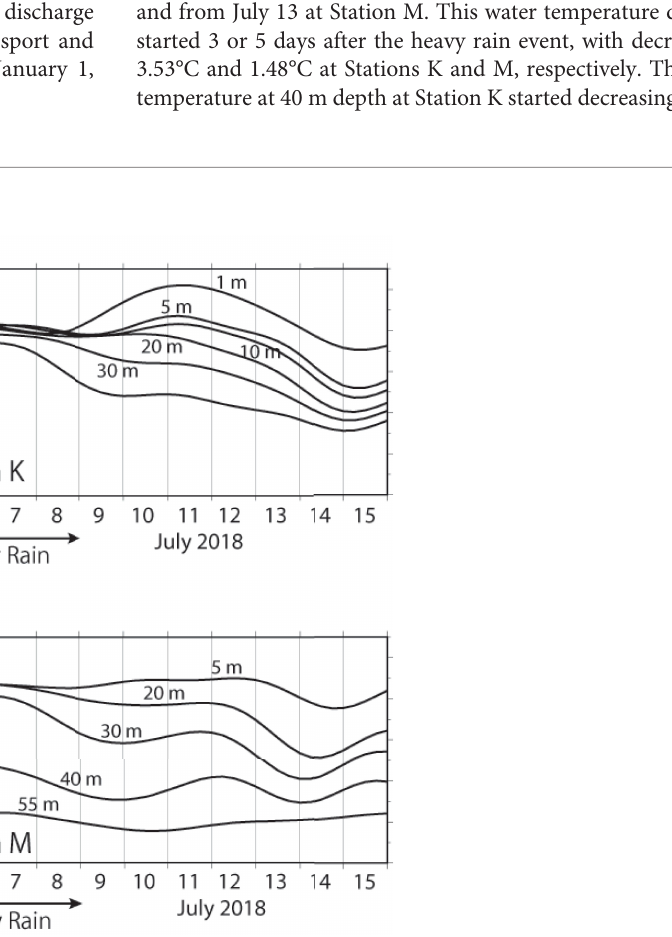
FIGURE 3 | Temporal variation in water temperature from July 5 to 15 (A) at 1, 5, 10, 20, 30, and 40 m depth at Station K and (B) 5, 20, 30, 40, and 55 m depth at Station